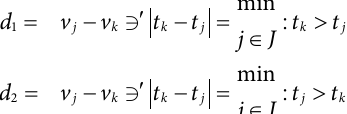
FiguRe 2 | Illustration of Steps 1–3: two serial movement records are concatenated; all local extrema were extracted (circles and squares; Step 1) and retained if occurring later than 0.5-s before the terminus of file 1 (diamond) or before the peak velocity in file 2 (last square; Step 2), and local min–max ranges were calculated (Step 3, dashed lines). Direction annotations in figure legend is Eb = East back (from East target back to center target), and SEt = Southeast toward (from center target toward Southeast target); see Section “Patient Population and